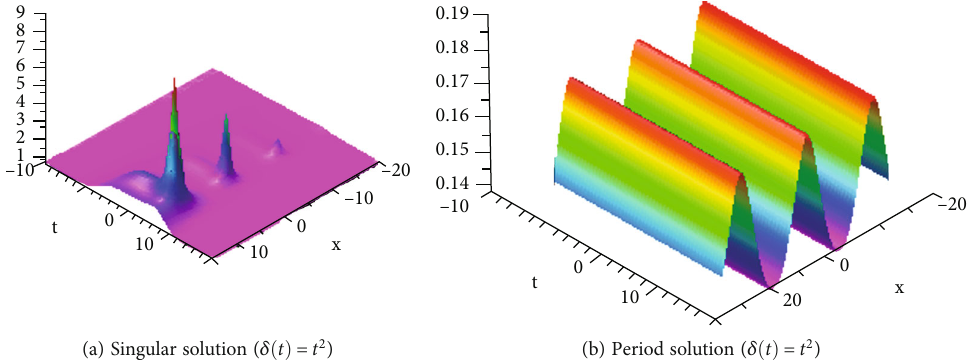
Figure 2: (a) Soliton solution with singularity when a = 0 : 1 and b = − 0 : 3 . (b) Spatial period soliton solution with parameter a = 0 and b = 0 : 2 , period M = 5 π